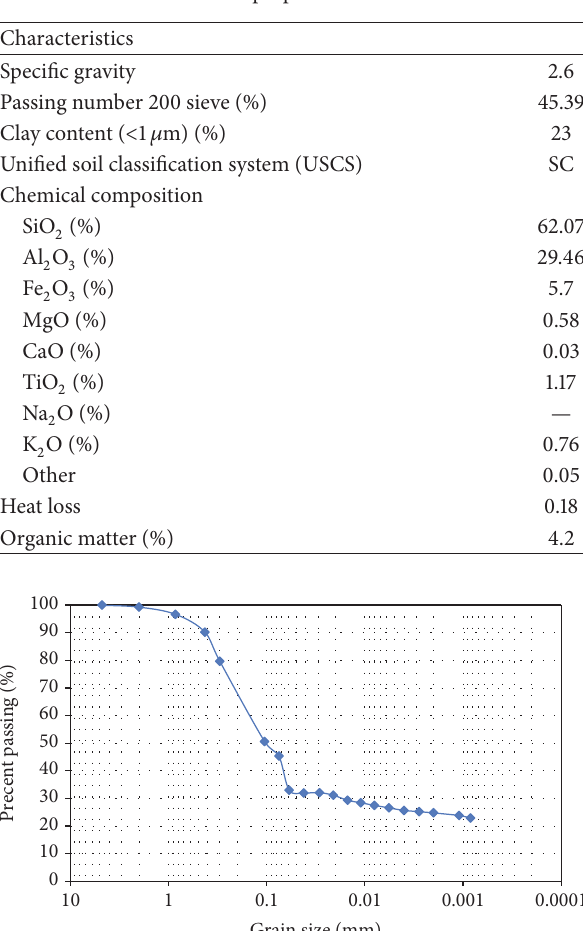
Table 1: Basic properties of UKM soil.